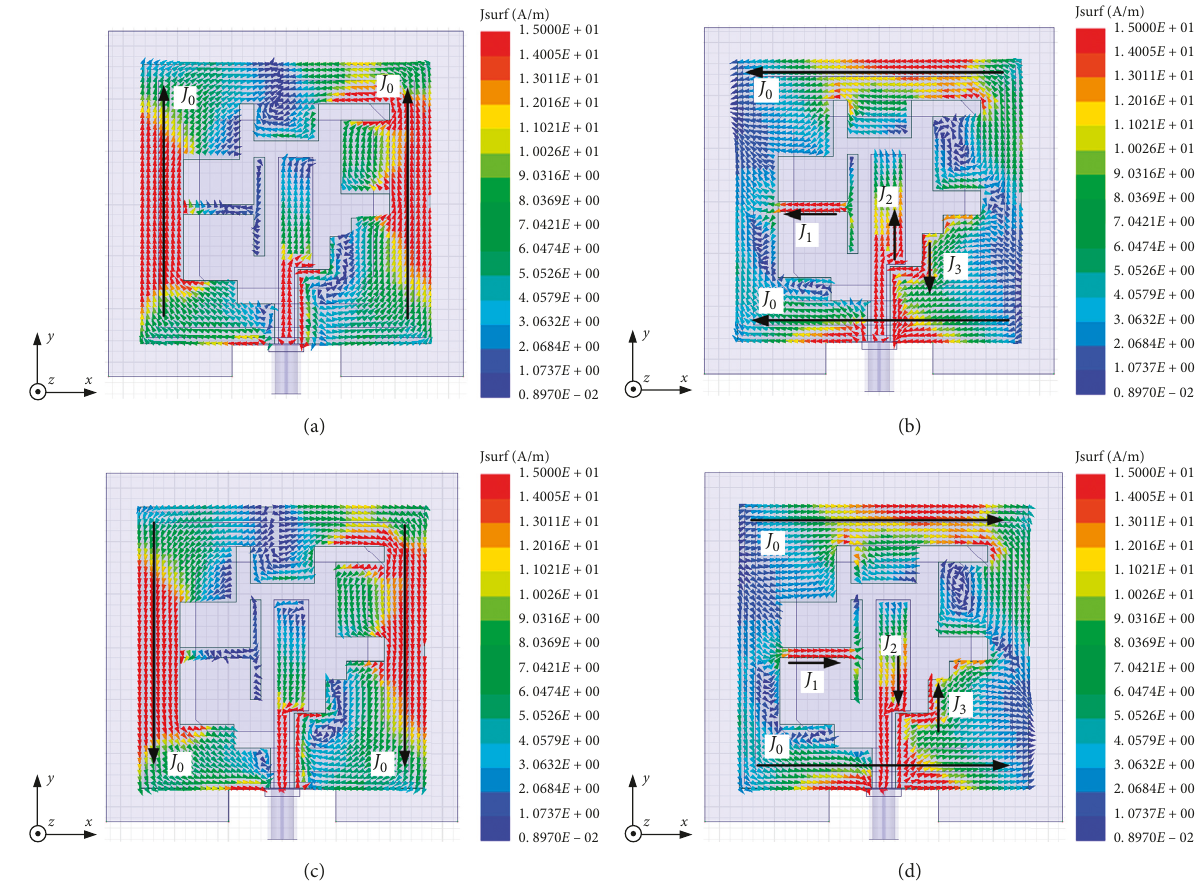
Figure 4: Simulated electric current distribution at 1.575 GHz. (a) t � 0, (b) t � T /4, (c) t � T /2, and (d) t � 3 T /4. T is the period of the sinusoidal fields with angular frequency ω